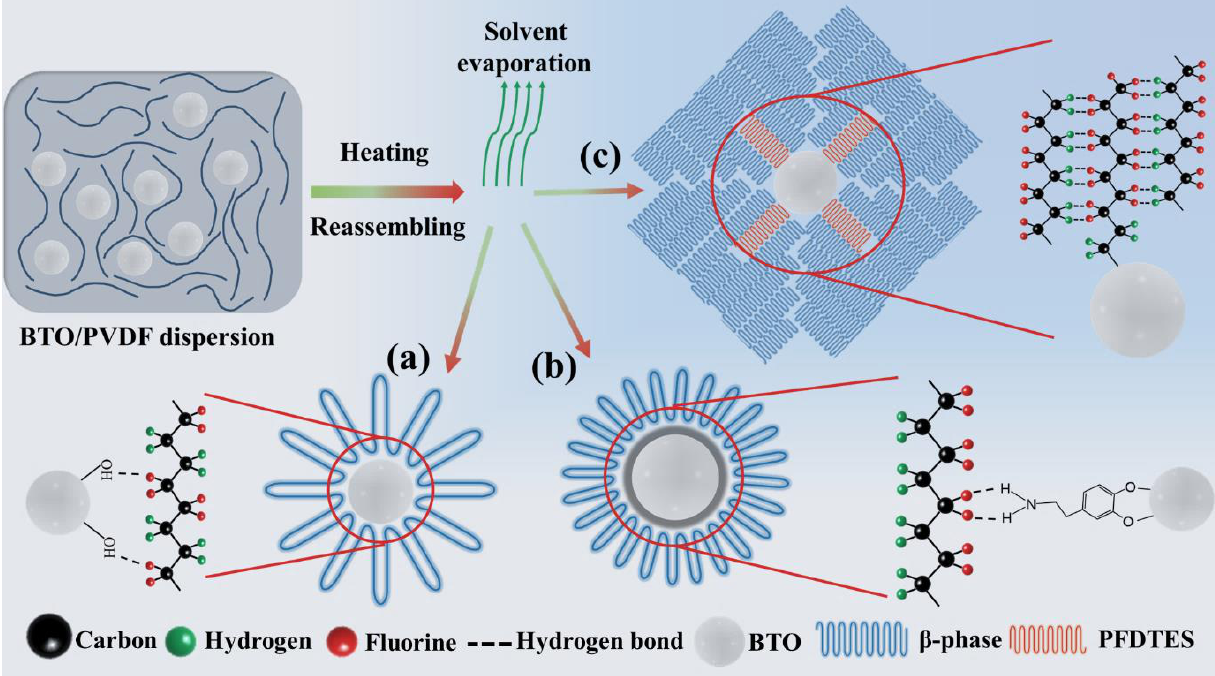
Figure 6. Schematic illustration of the transformation of α-phase to β-phase in the PVDF film by inclusion of ( a ) BTO or ( b ) FDA-BTO or ( c ) PFD-BTO NPs.